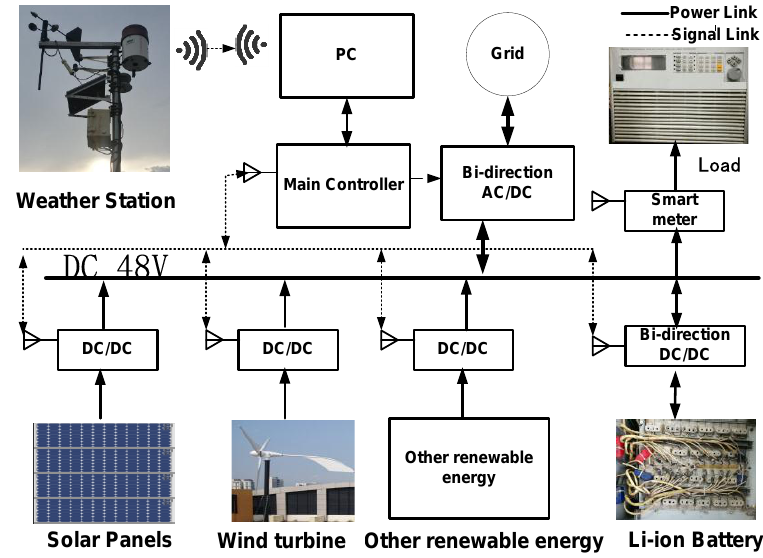
Figure 3. Experimental setup.